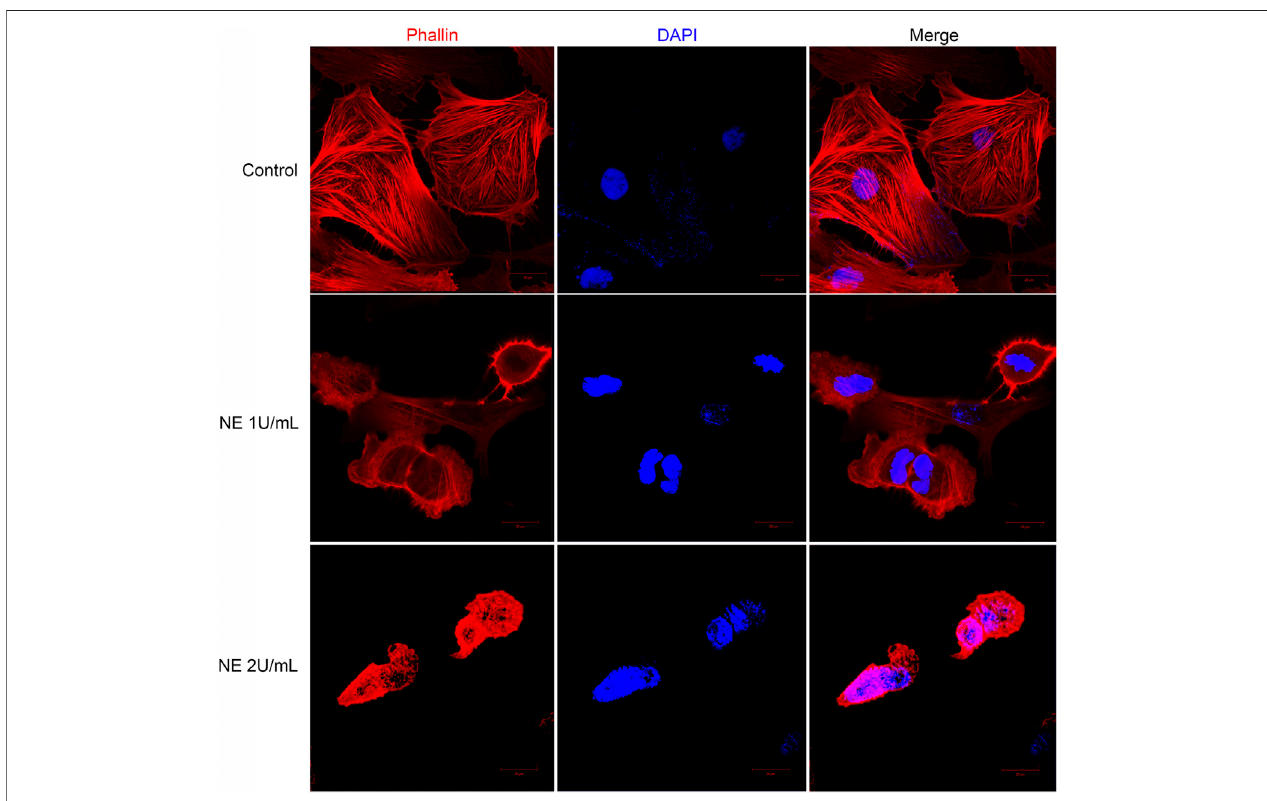
FIGURE7| Neutrophilelastaseinducesretractionofchondrocytesanddisruptsactincytoskeleton.Representativeconfocalphotomicrographsofcytoskeletonon chondrocytes treated with different dose of NE. Cells were fi xed and stained with TRITC-phalloidin (red) and nuclei were stained with DAPI (blue). Original magni fi cation, ×